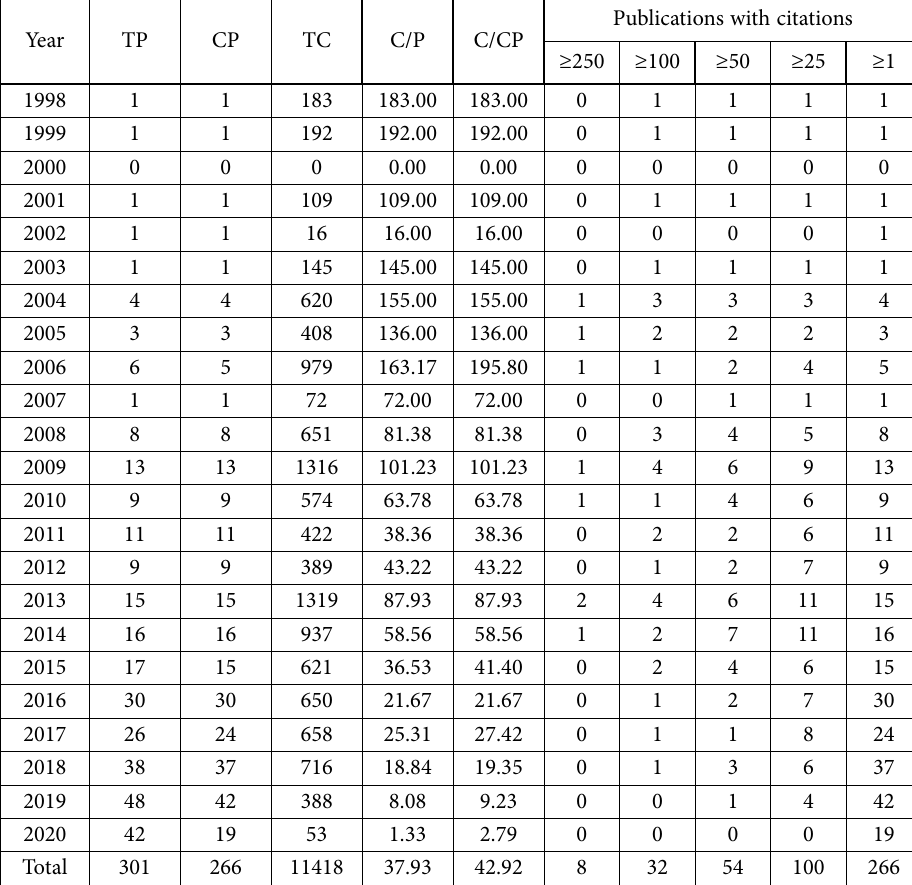
Figure 1. Publications and citations per cited paper from 1998 to 2020 (by October 2020) Table 1. Publication trend and citation structure from 1998 to October